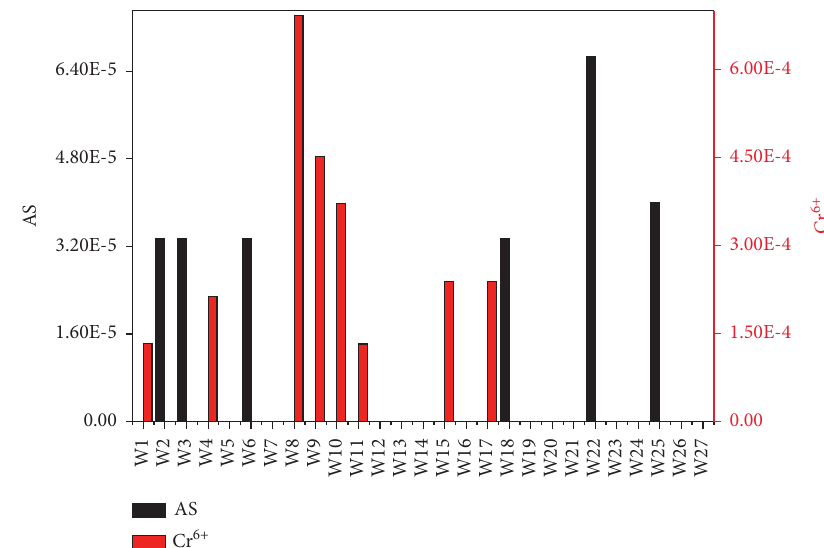
Figure 9: Carcinogenic risk of the groundwater samples for